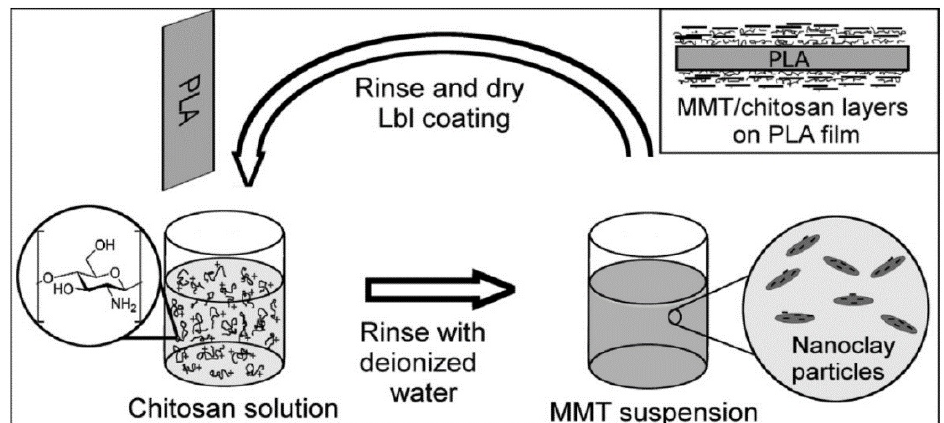
Figure 3. Schematic representation of layer-by-layer (Lbl) deposition of chitosan and montmorillonite (MMT) on extruded poly(lactic acid) (PLA) film. Reprinted with permission from Ref [94]. Copyright (2012) American Chemical Society. Table 1. Barrier improvement factors (BIFs) for PLA/clay nanocomposites.